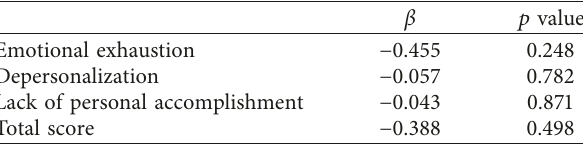
Table 2: Relationship between burnout dimensions and age in participants using linear regression.